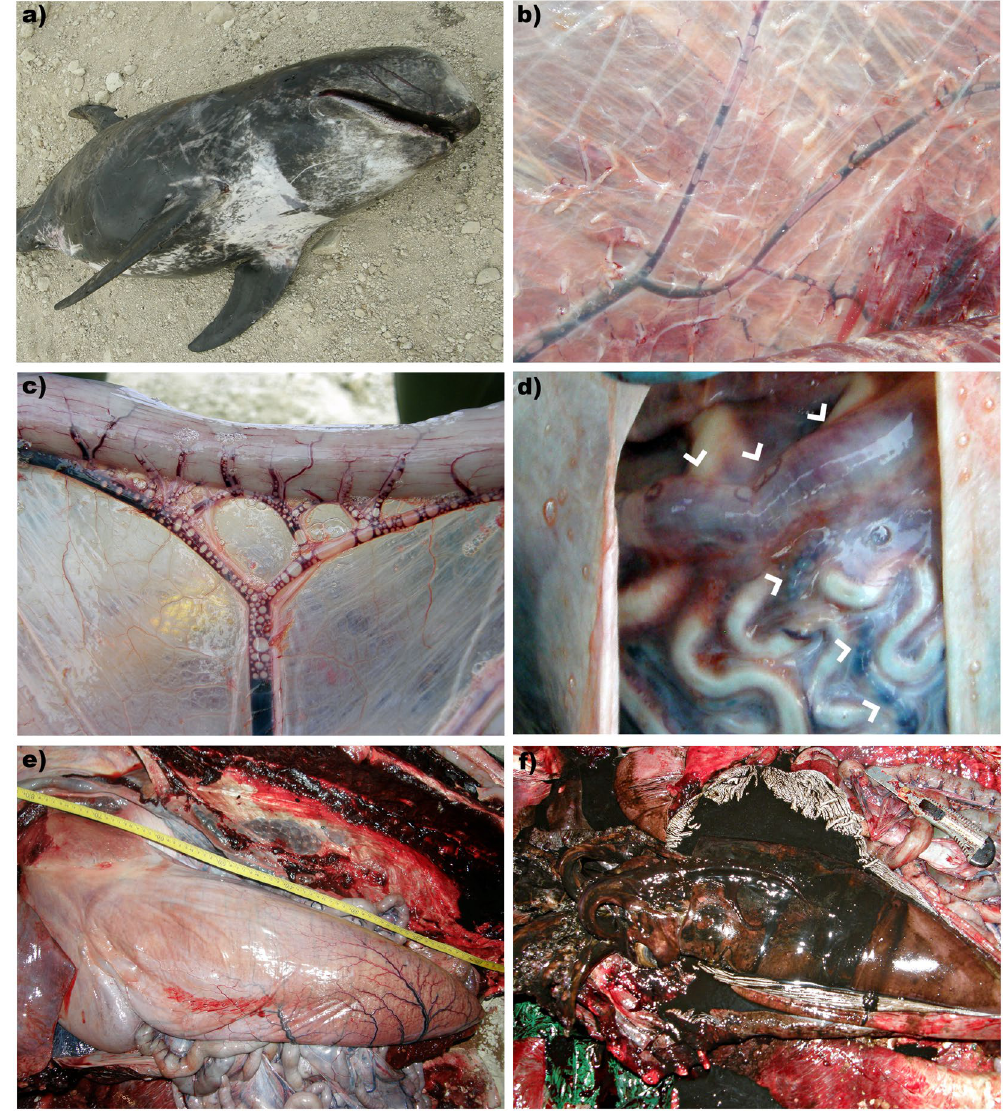
GFVD in the coronary veins (arrow